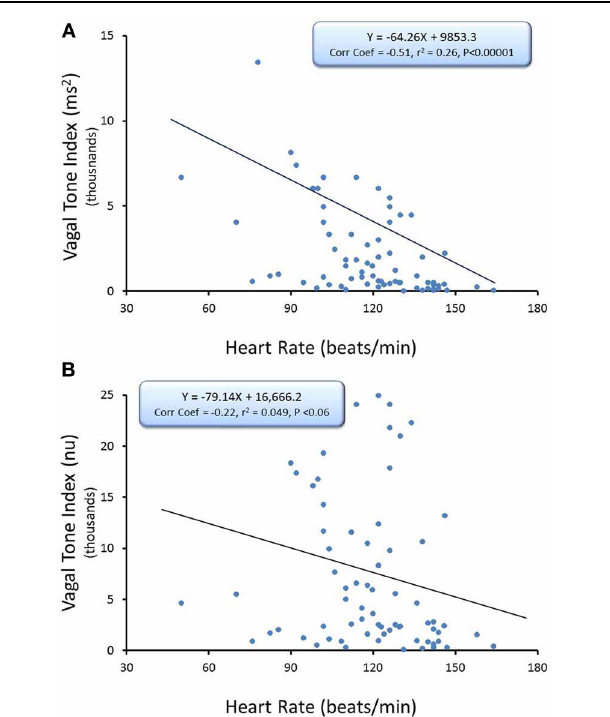
FIGURE 3 | The relationship between baseline heart rate and heart rate variability. The high frequency (HF) component of the R-R interval variability (cardiac vagal tone index, 0.24–1.04 Hz) was calculated for over the last 30s before an autonomic intervention was administered and plotted against the average HR for that interval. One data point is displayed for each animal ( n = 74). The data without and with HR correction [cardiac vagal tone index/(mean RRsec) 2 ] are displayed in (A,B) , respectively. Note that HR only accounted for less than 30% ( r 2 = 0 . 26) of the variability before correction for HR. nu, normalized units following HR correction.